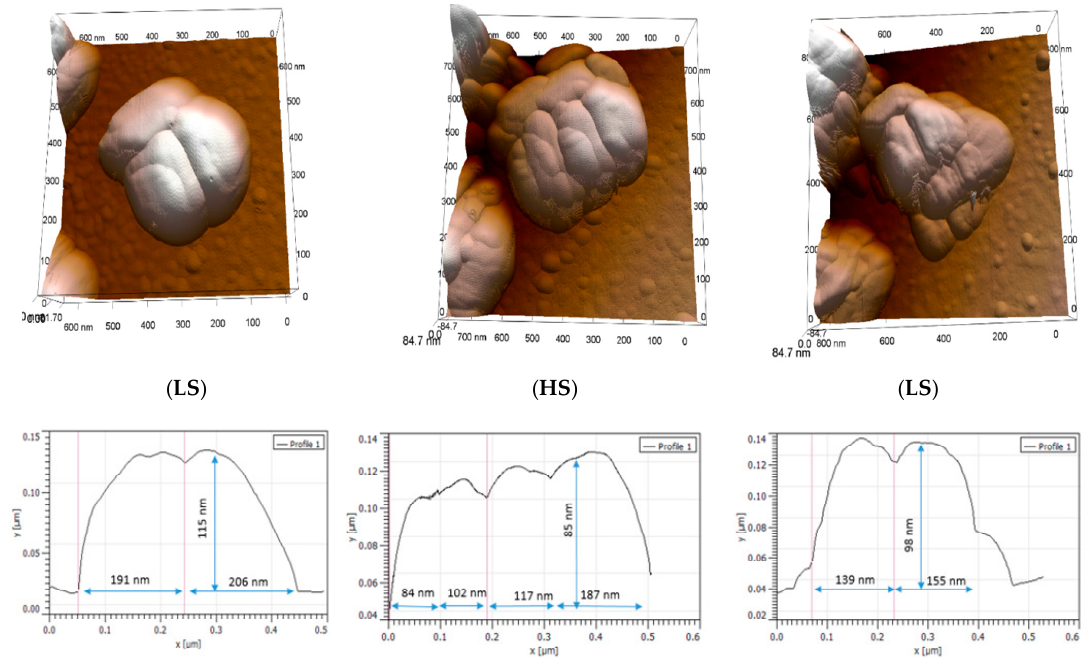
Figure 2. AFM height images and cross-sections of a particle of 1 acquired in different spin states at 358 K over a complete thermal cycle. From left to right: LS, HS and LS states. Images were recorded at 512 × 512 pixels at a line rate of 2 Hz. The z-scales range from 0 to 168 nm.